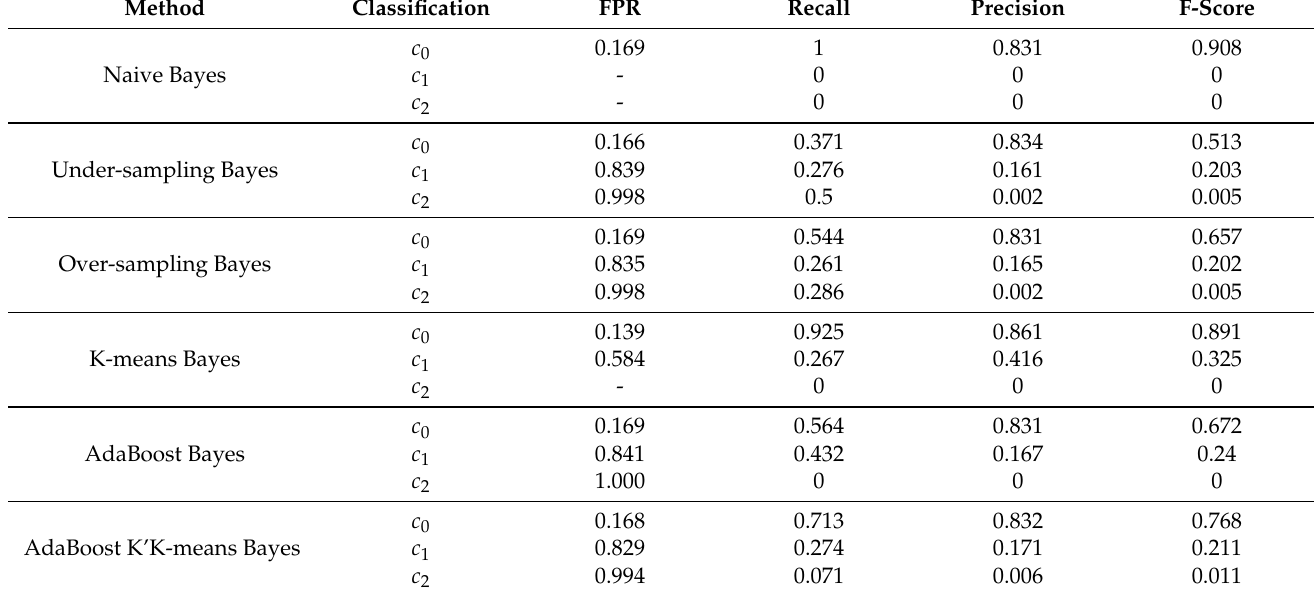
Table 2. The results of different